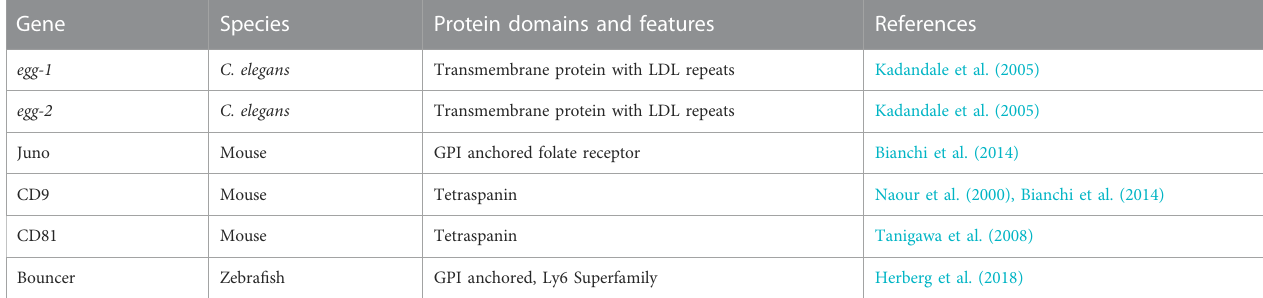
TABLE 1 Egg surface fertilization molecules.